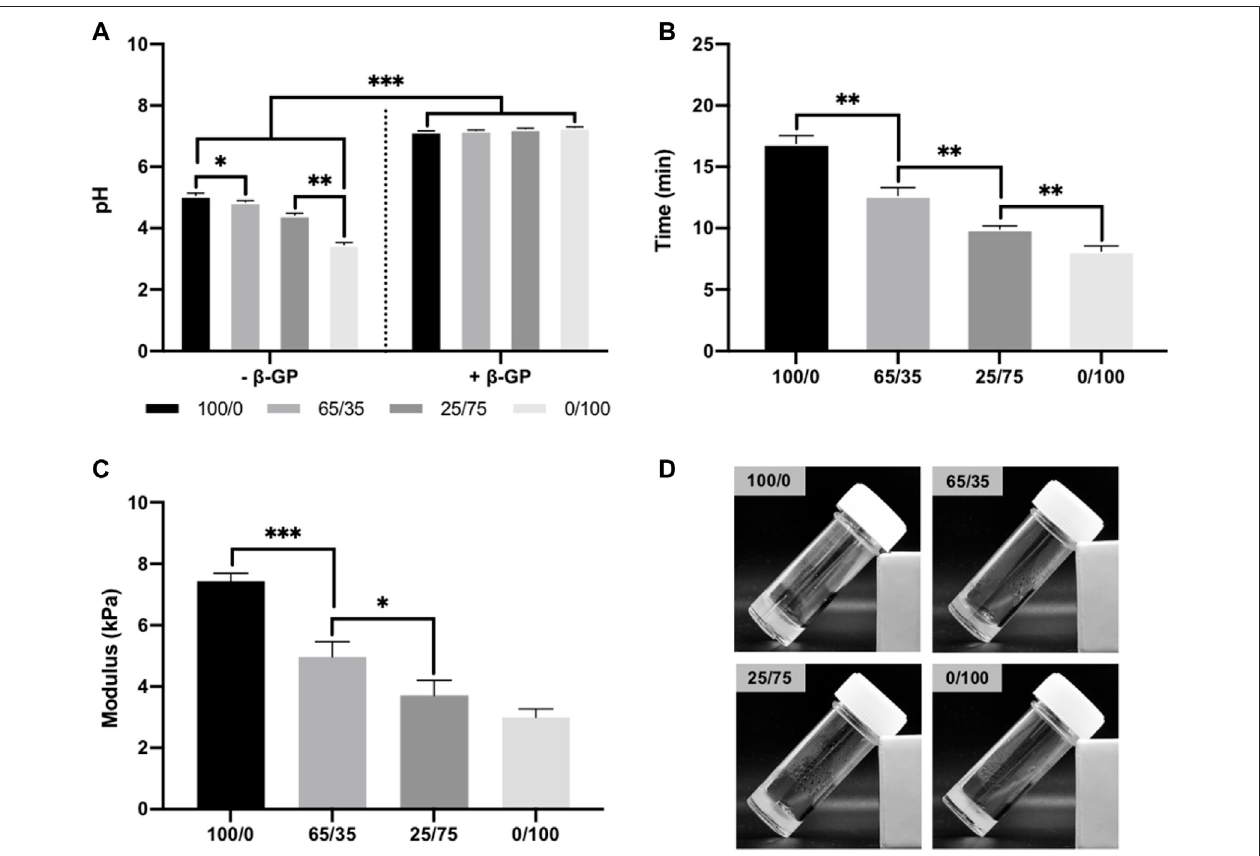
FIGURE 2 | Physiochemical properties of chitosan-collagen hydrogels. (A) pH of composite hydrogels before and after β -GP addition. (B) Gelation time of hydrogels at 37 ° C. (C) Compressive modulus. (D) Macroscopic image of hydrogels after gelation. Data are expressed as mean ± SD ( n = 3). * p ≤ 0.05, ** p ≤ 0.01, and *** p ≤